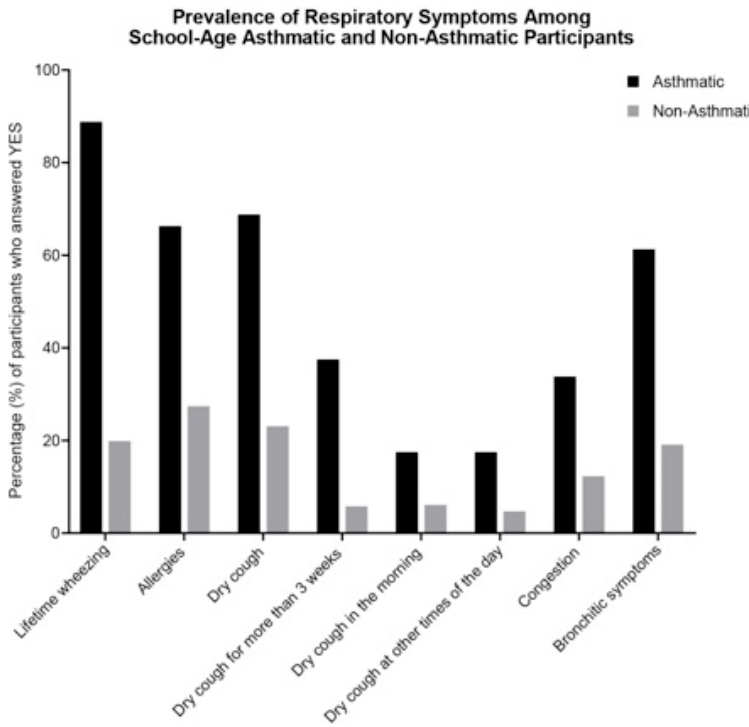
Figure 1. Prevalence of reported respiratory symptoms among school-age participants. Bars represent percentage of asthmatics ( n = 80; black bars) and nonasthmatics ( n = 277; gray bars) who were reported to have any of the listed respiratory symptoms in the past 12 months, unless otherwise specified.